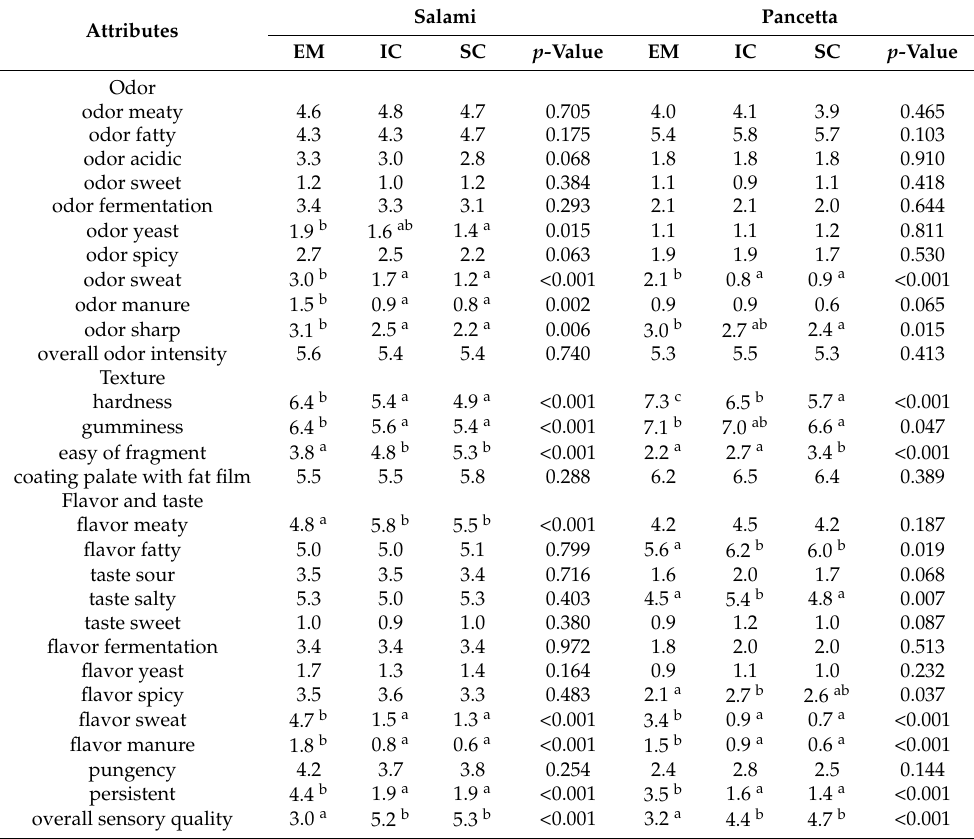
Table 2. Sensory profiling of the EM, IC and SC salami and pancetta products ( n =